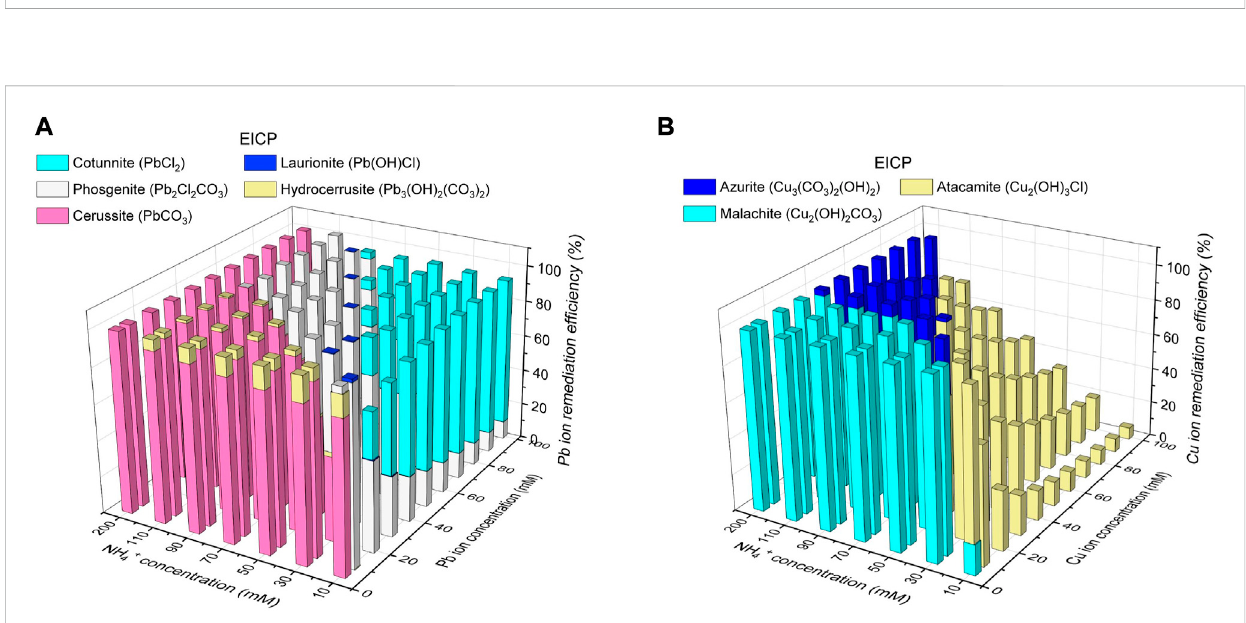
FIGURE 6 (A) Variationsofremediationef fi ciencyagainsthydrolyzedureaconcentrationandPb 2+ concentrationunderMICP and (B) variationsofremediation ef fi ciency against hydrolyzed urea concentration and Cu 2+ concentration under MICP.